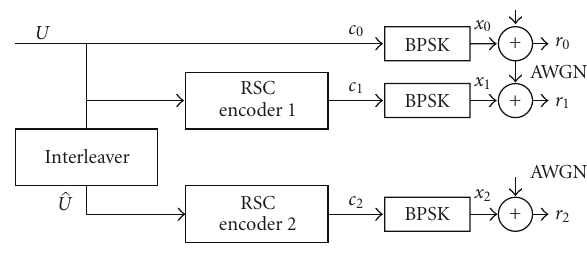
Figure 3: An essential turbo encoder.